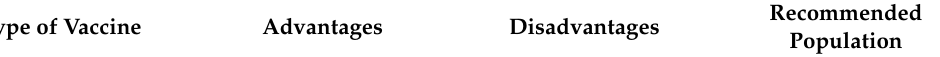
Table 3. Influenza Vaccine Types and